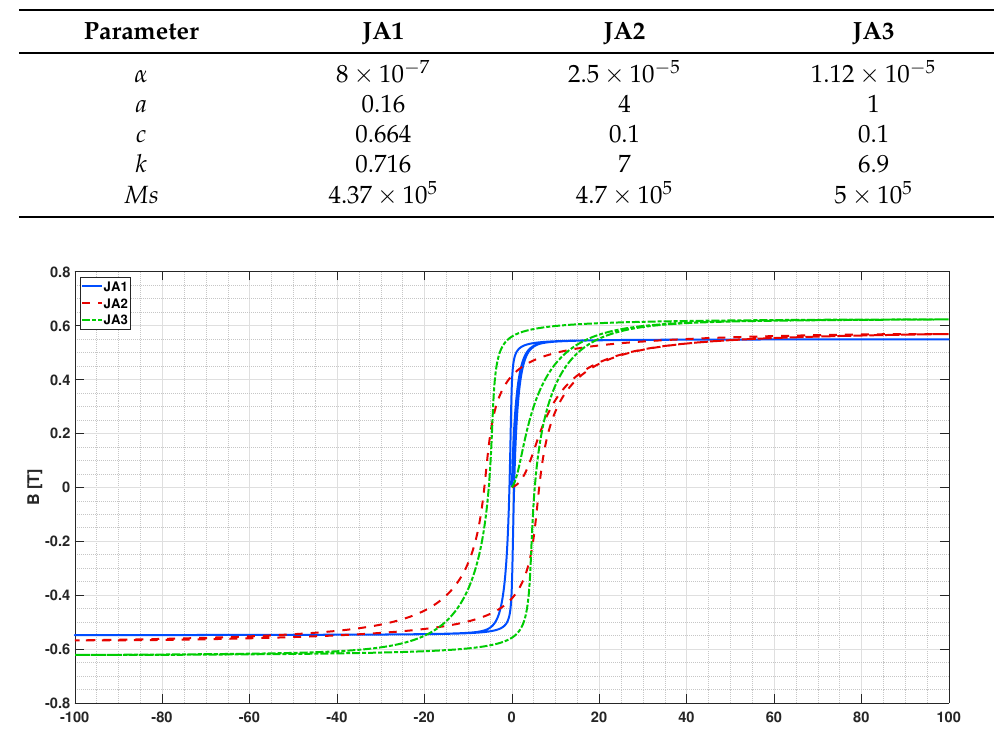
Table 2. Jiles–Atherton parameters of the fitted curves JA1, JA2, and JA3.